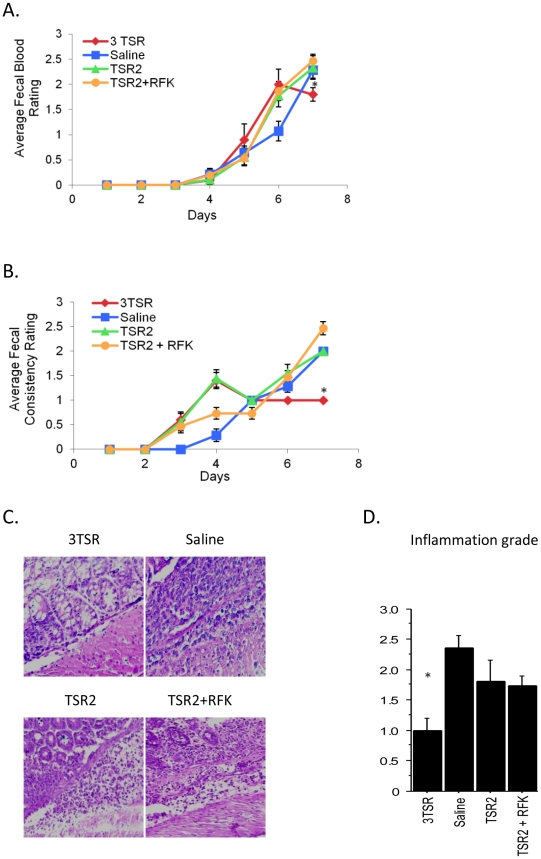
Fecal blood and consistency rating in mice treated with DSS and TSRs over one week.While no significant differences were observed during the first days of treatment, by days 6 and 7, mice treated with the 3TSR (n = 10) showed lesser fecal bleeding when compared with mice treated with the saline (n = 14), TSR2 (n = 9) and TSR2+RFK (n = 15), (day 6: p = 0.02; day 7: p = 0.045, asterisk) (A). Fecal consistency was also evaluated daily (B). By day 7, 3TSR mice displayed more solid feces compared to the liquid feces of saline-treated mice (p<0.0001, asterisk) and TSR2+RFK (p<0.0001). Inflammation grading (C, D) was assessed and H&E stained sections. Decreased inflammation was observed in sections of colons from 3TSR-treated mice (n = 9) compared to colons from mice treated with TSR2+RFK (n = 12), TSR2 (n = 10) and saline (n = 7). 400× original magnification.